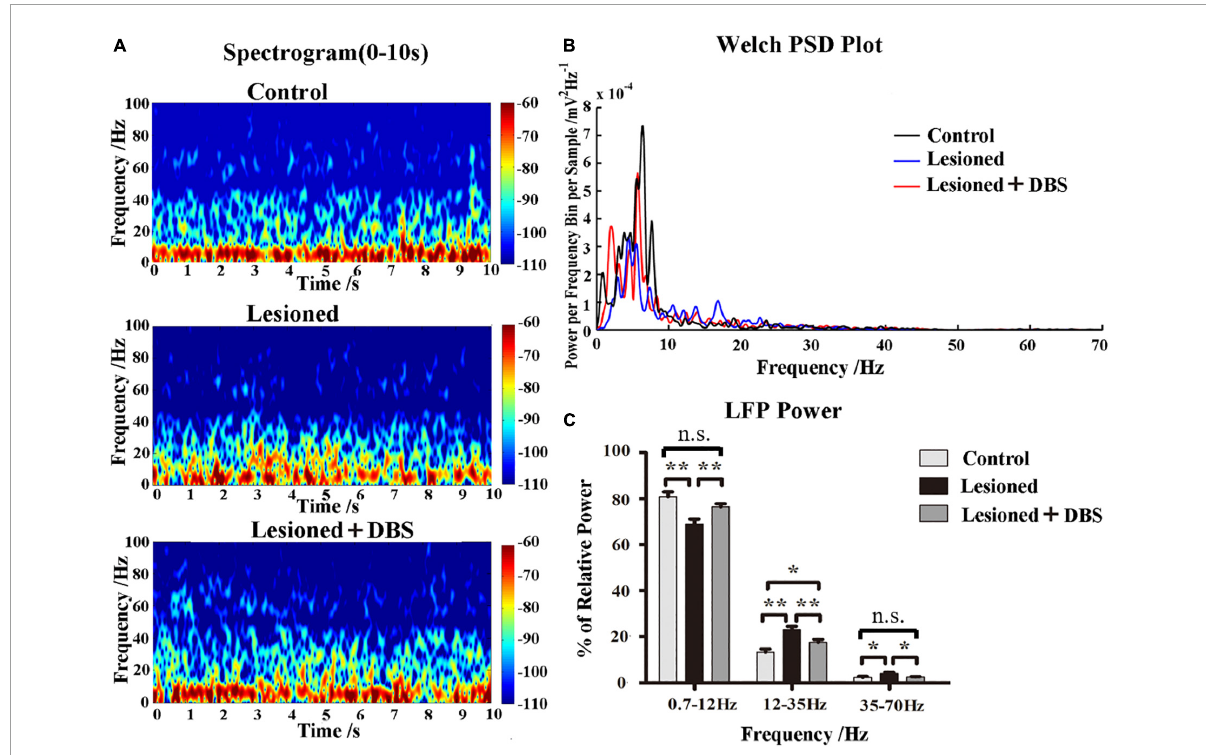
FIGURE4 Effects of GP-DBS treatment on the local field potential (LFP) in the PF. (A) Time-frequency spectrograms of LFP powers in the PF from control, 6-OHDA-lesioned, and DBS-treated rats. (B) Welch estimation analysis of LFP powers in the PF from control, 6-OHDA-lesioned, and DBS-treated rats. (C) Relative LFP powers with a series of frequency ranges: 0.7–12, 12–35, and 35–70 Hz in control, 6-OHDA-lesioned, and DBS-treated rats. * p < 0.05, ** p <